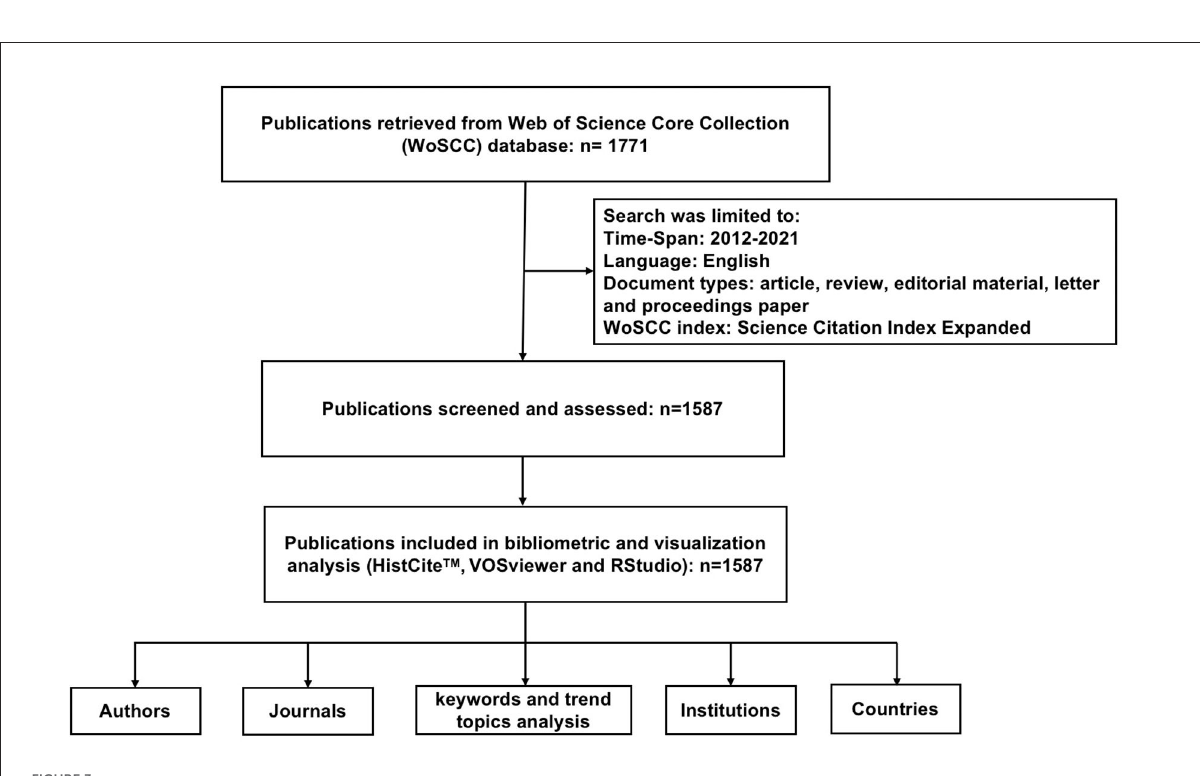
FIGURE3 A publications selection flow chart included in the final